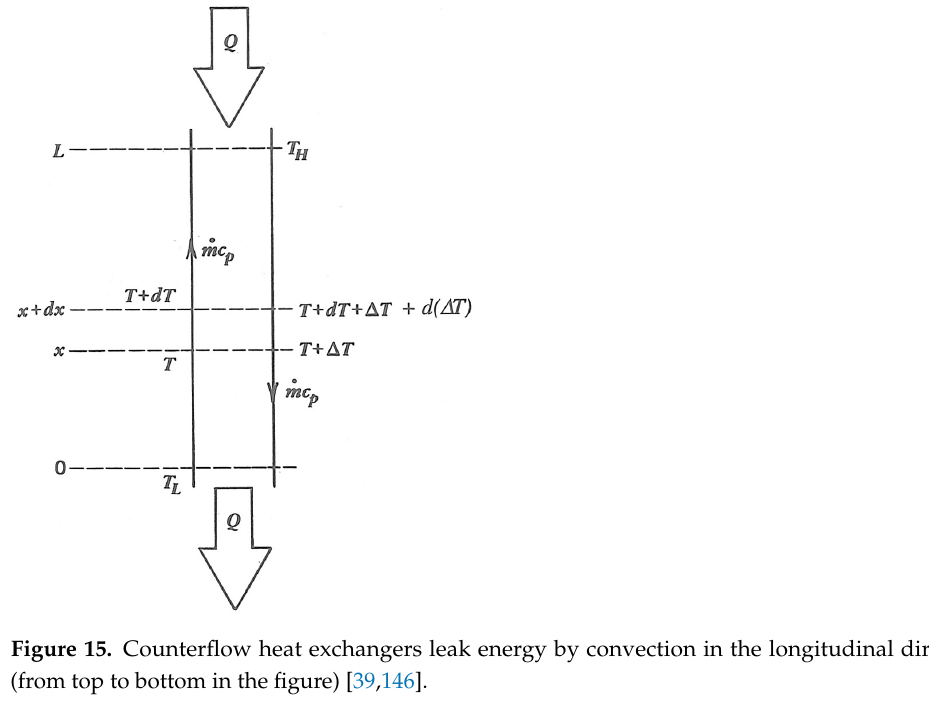
Figure 16. The Brayton cycle power plant (Figure 6, middle) has three heat exchangers [heater (H), counterflow (R), and cooler (C)], and each generates entropy (N S ). The total rate of entropy genera- tion of the Brayton power plant (N S,B ) decreases monotonically as the size of the counterflow (or ε ) increases [21,148].